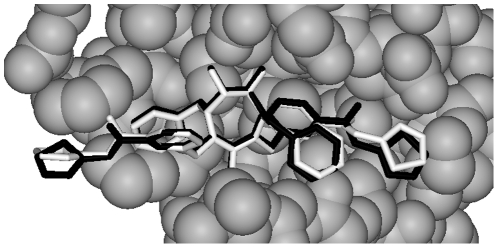
Ligand conformation selection.HIV-1 protease crystal structure 1BV7 with native ligand XV638 (gray) from the Protein Data Bank is shown with a superimposed modeled XV638 ligand (RMSD, 0.71, black) whose conformation was selected out of 45 candidate conformations by internal consensus analysis. Of the 45 conformations, 4 had RMSD values less than 2.0. Most native VDW contacts between protein and ligand are conserved (56/84 contacts with a 0.8 Angstrom threshold). Mottling of ligand occurs where the native and modeled structure are tightly aligned.